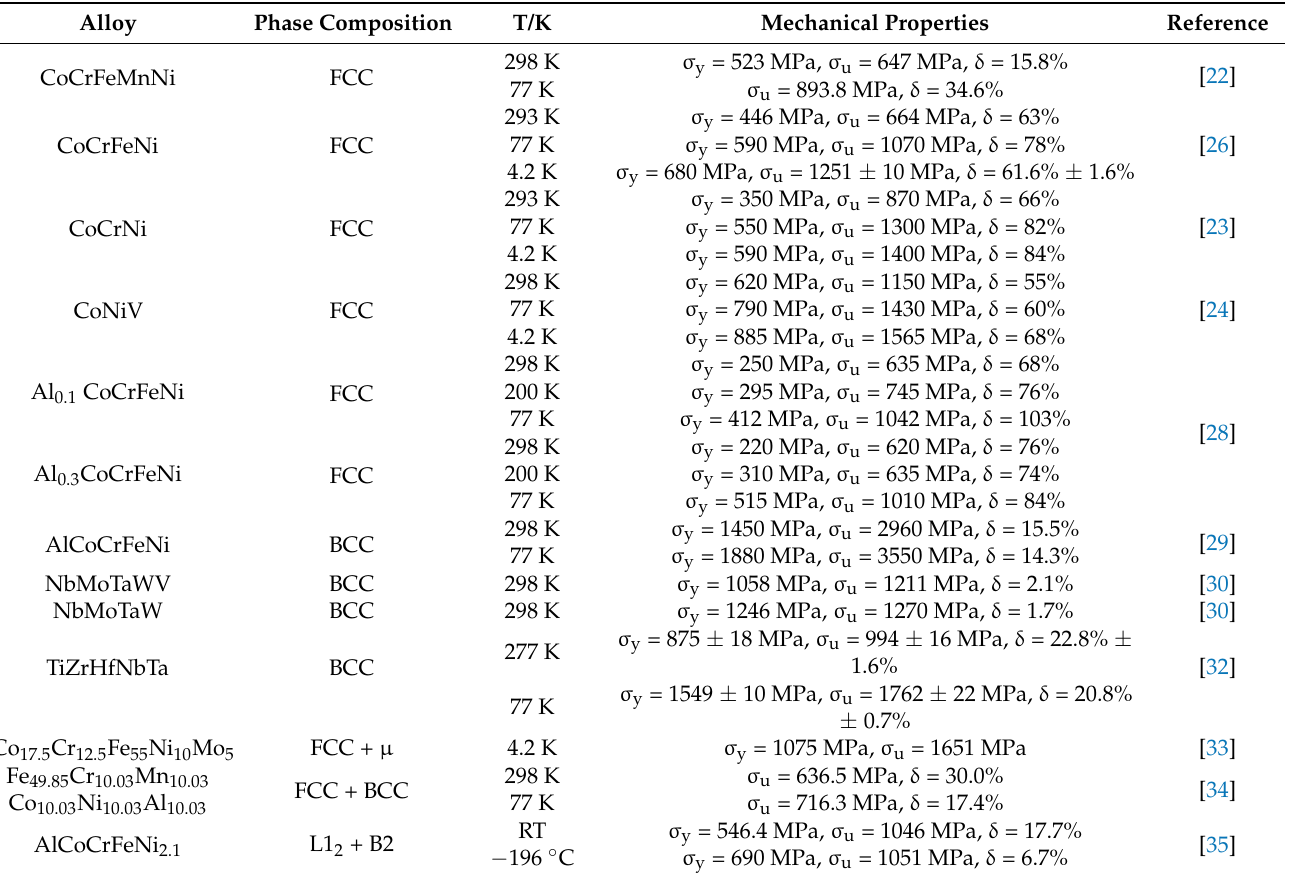
Table 1. Phase composition, micro-structure and mechanical properties of some HEAs at room temperature and cryogenic